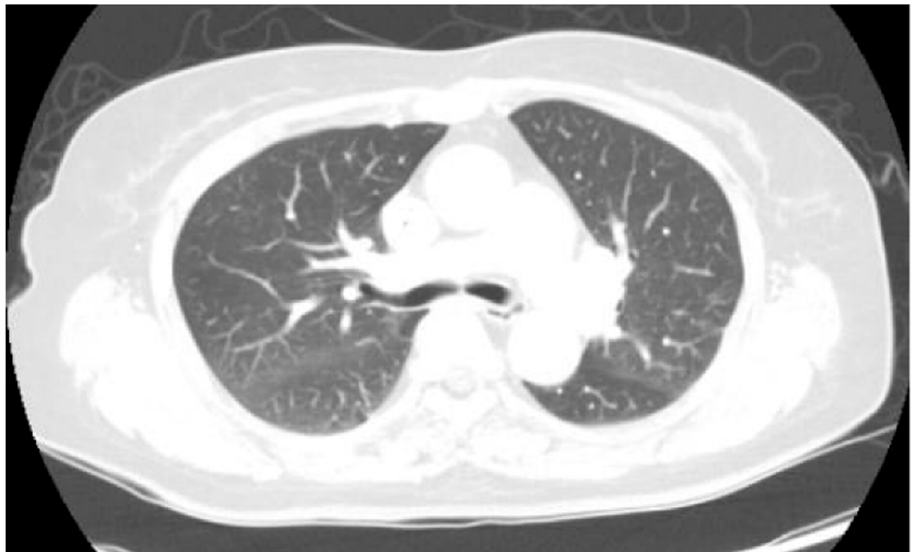
Figure 3. Follow-up chest CT after intravenous antibiotic treatment. A representative axial image reveals complete resolution of the lung lesions that were observed in the earlier PET/CT scan.